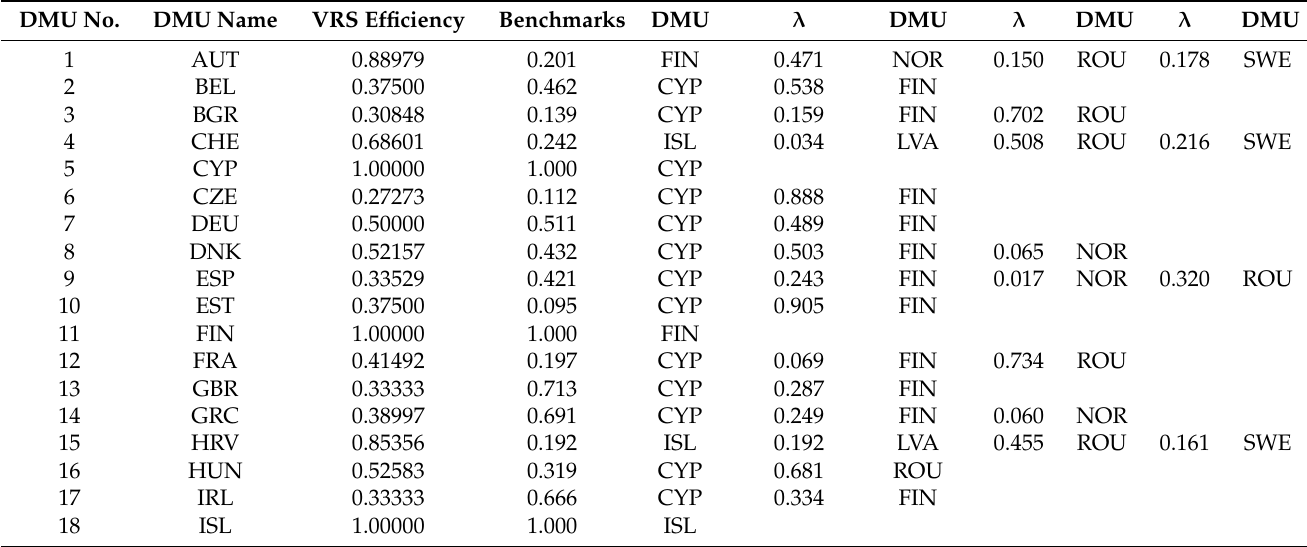
Table A18. Input-Oriented VRS Efficiency of EPS in 2006. Source: Authors’ calculations in DEAFrontier. DMU